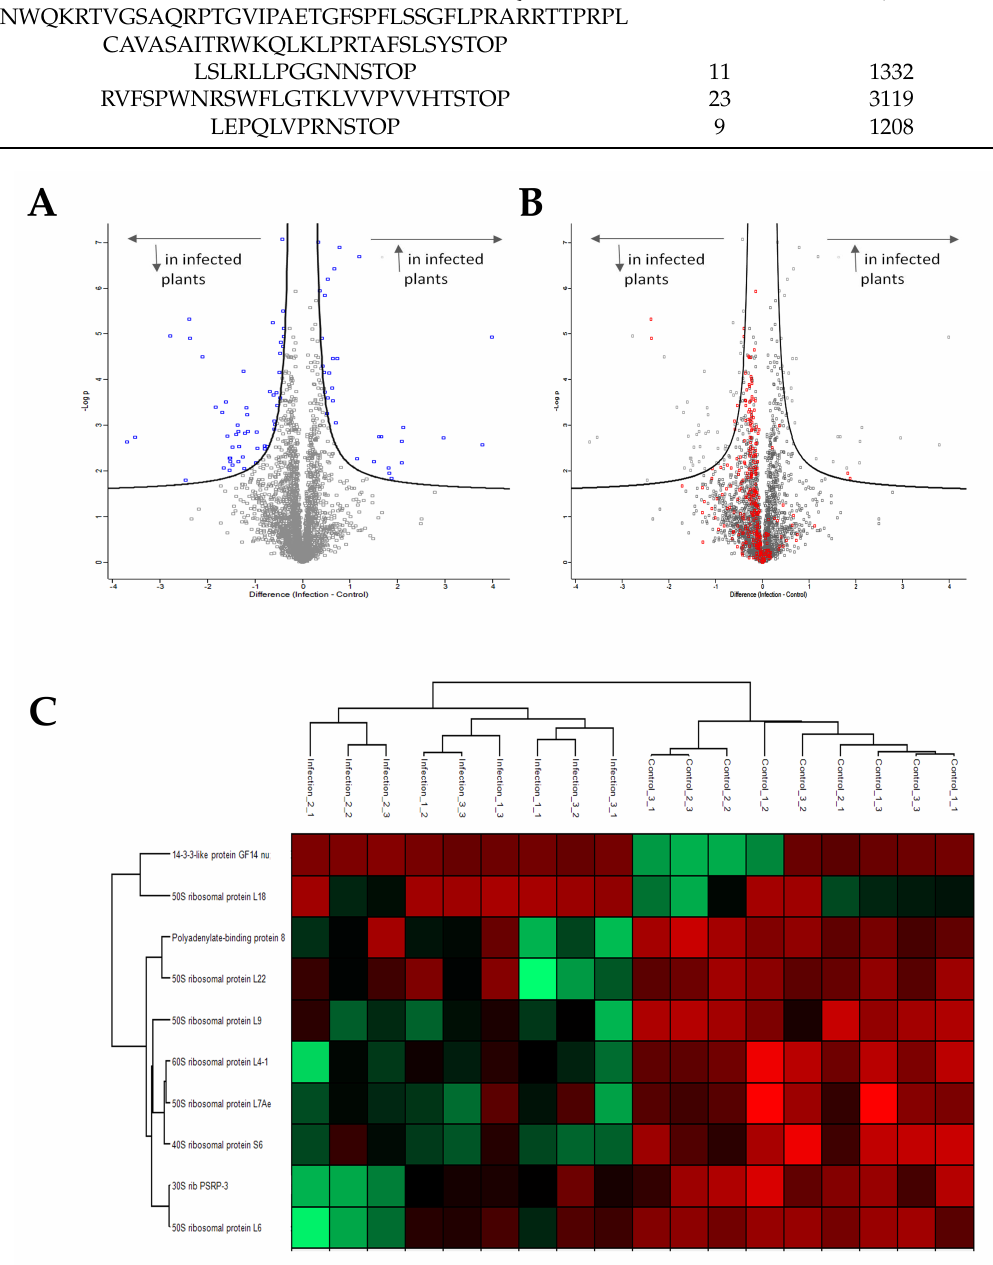
Figure 7. MS analysis. ( A ) Volcano plot showing all proteins affected in PSTVd-infected N. benthami- ana plants. In total, 85 proteins were shown to be statistically affected. ( B ) Volcano plot showing proteins related to the translation mechanism affected upon PSTVd infection of N. benthamiana plants. ( C ) Heat map of proteins related to translation statistically affected by the infection of PSTVd. All graphs were created using the Perseus 1.6.10.43 software [52]. More details in Table